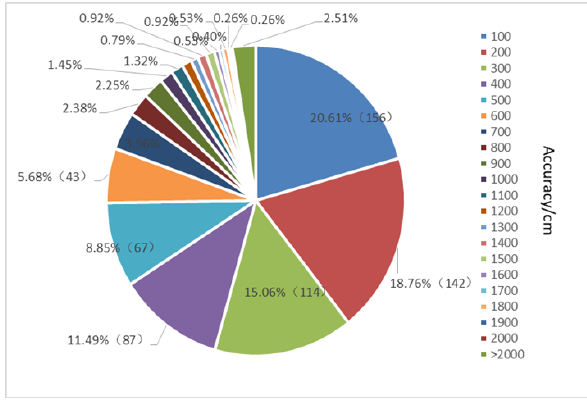
Figure 2. Accuracy